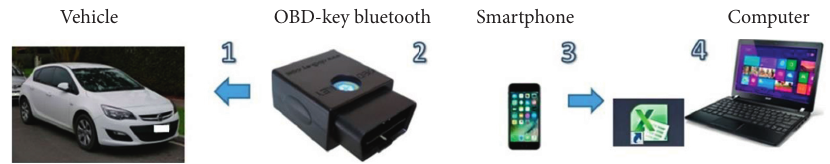
Figure 3: Data acquisition